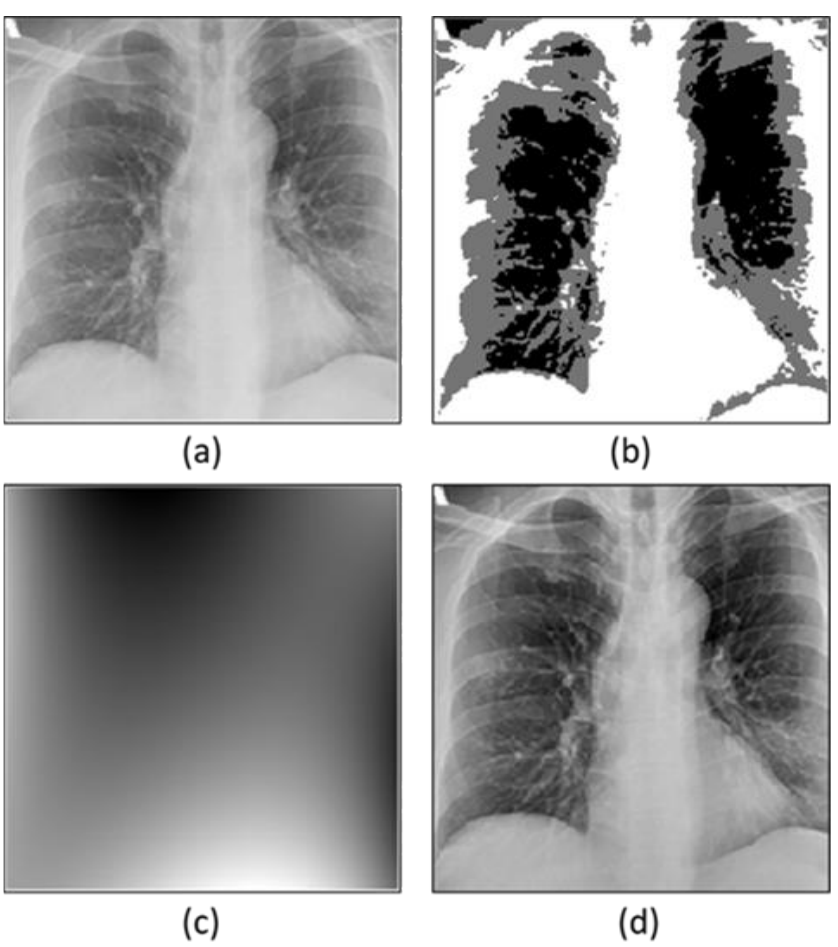
Figure 2. Application of bias field correction of the X-ray image. ( a ) Original image, ( b ) segmentation of inhomogeneous intensity, ( c ) estimated bias field image, ( d ) bias field correction image.